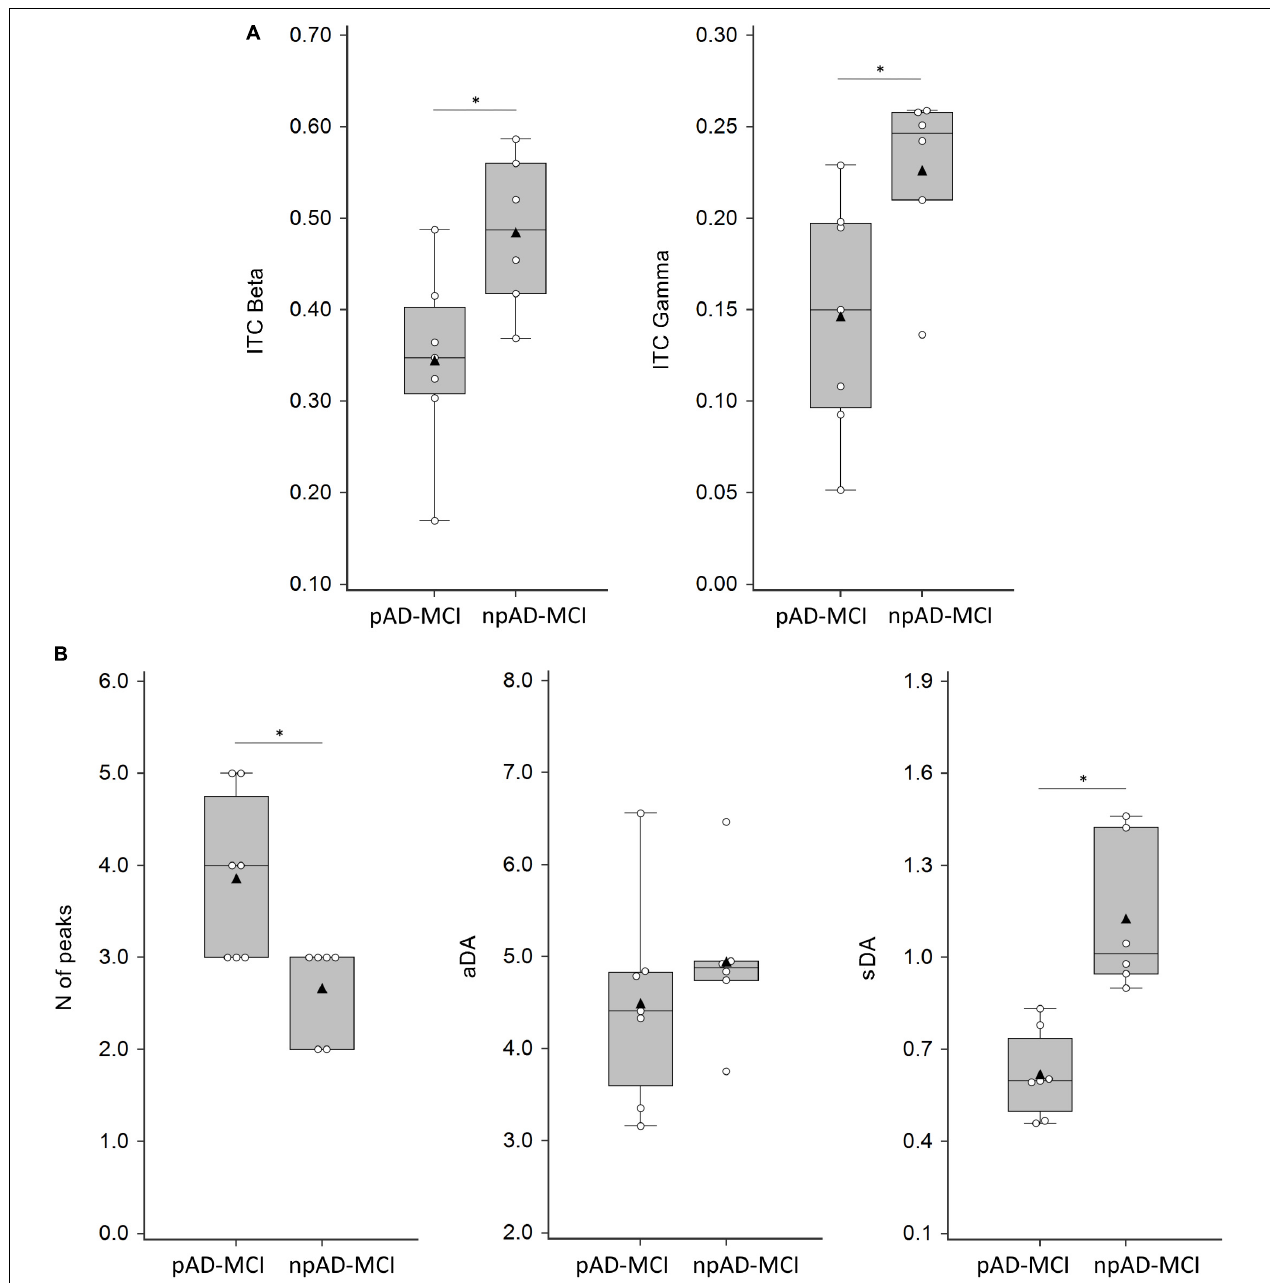
FIGURE 4 | ITC, numbers of peaks, average dipolar activity (aDA), and stability of the dipolar activity (sDA) parameters in MCI groups. (A) ITC values in the beta (average of C3, FC1, and FC5 channels) and gamma (FC1 channel) frequency band in pAD-MCI and npAD-MCI. (B) Numbers of peaks, aDA, and sDA in pAD-MCI and npAD-MCI. White dots indicate the individual data, while black triangles denote the mean values. Horizontal lines indicate the median value (50th percentile). The boxes contain the 25th to 75th percentiles of dataset. Asterisks indicate significant differences between the